Question: How would you classify this visualization?
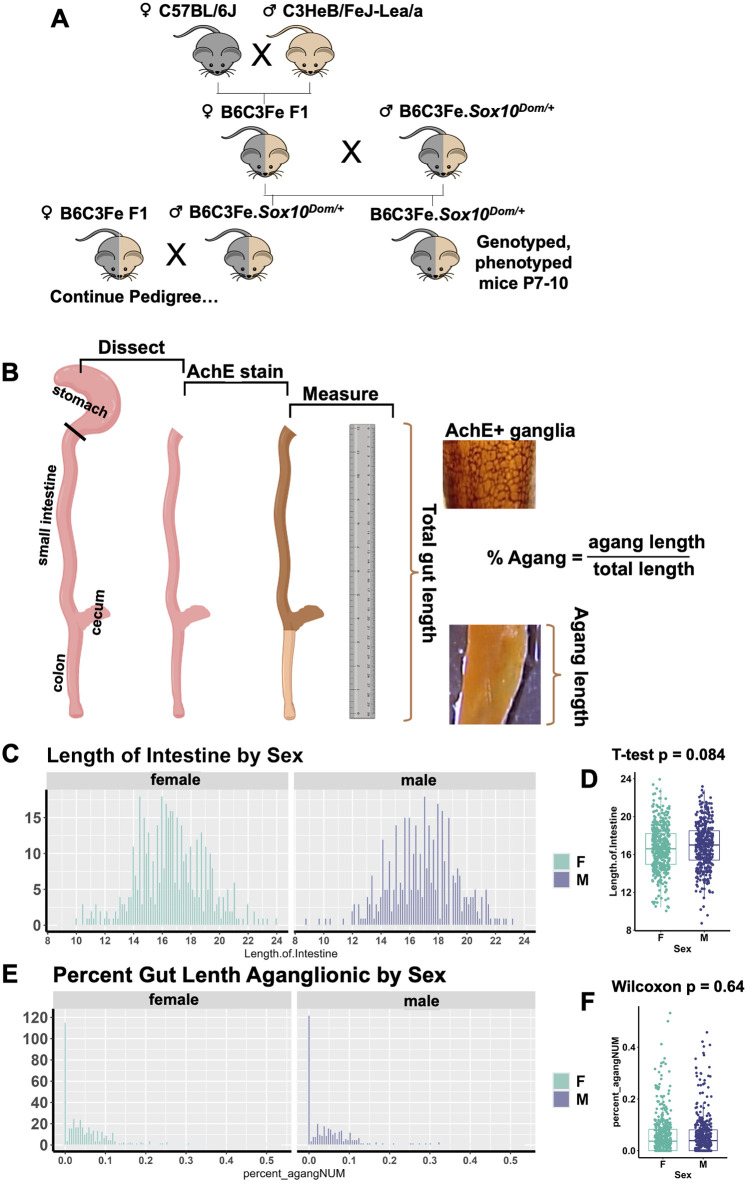
Answer: box